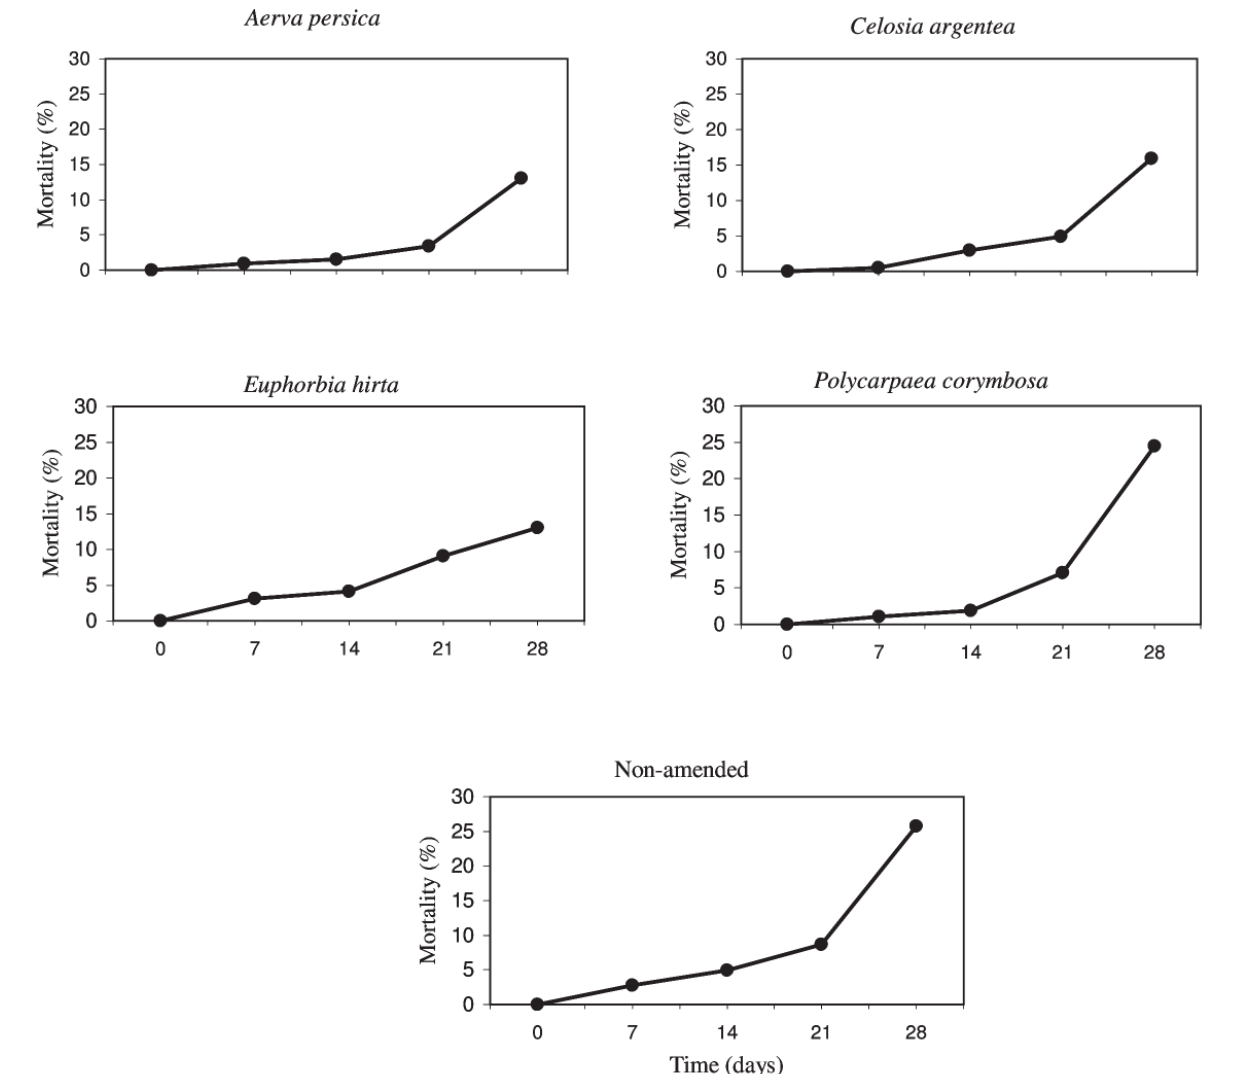
Fig. 2. Development of dry root rot on clusterbean after initiation of disease from September 7, 1999 onwards in weed residue amended and non-amended plots (LSD [ P =0.05]: Treatment 0.24; Time in days 0.19; Treatment (cid:1) Time in days [of a particular amendment] 0.41; and Treatment (cid:1) Time in days [at a fixed interval]